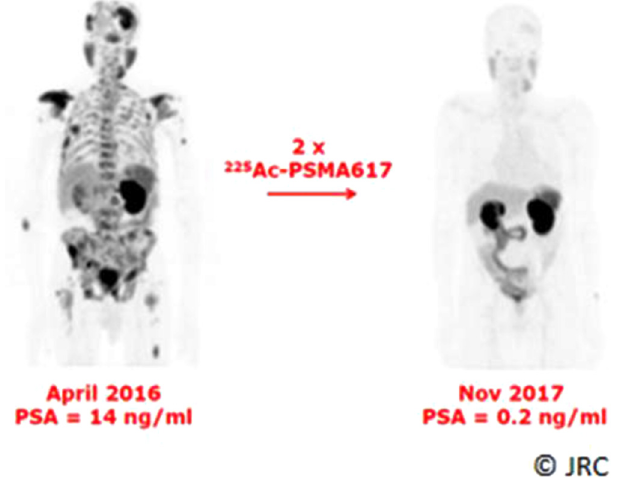
Fig. 2. Targeted alpha-immunotherapy.